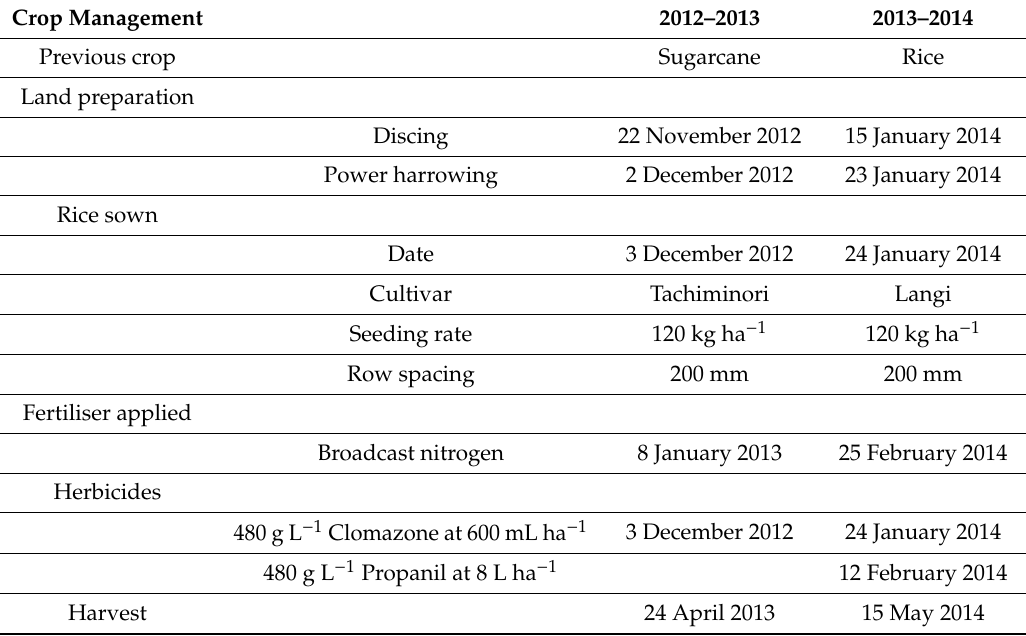
Table 2. Crop management calendar for rice field trials in 2012–2013 and